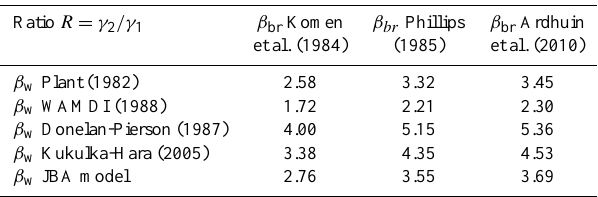
Table 2. Same as Table 1, but Elfouhaily et al.’s (1997) wave spec- trum is replaced by Kudryavtsev et al.’s (2003) spectrum at high wavenumbers ( k ≥ 25 k p